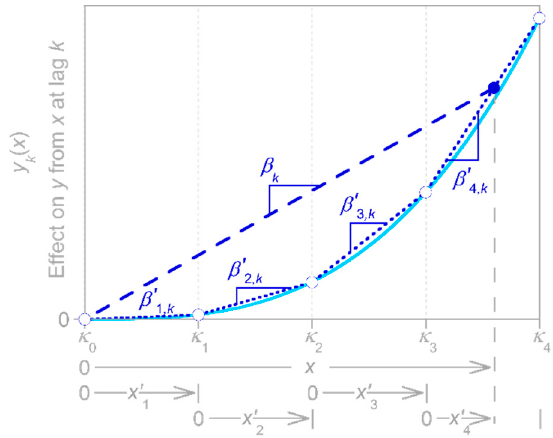
Figure 8. Broken ‐ stick approximation to nonlinear impulse response. Schematic of the (unknown) Figure 8. Broken-stick approximation to nonlinear impulse response. Schematic of the (unknown) nonlinear dependence of output 𝑦 on input 𝑥 at some lag 𝑘 , and its approximation by a piecewise nonlinear dependence of output y on input x at some lag k , and its approximation by a piecewise linear linear function defined by knots 𝜅 ℓ and the associated slopes 𝛽 ℓ,(cid:3038)(cid:4593) of each segment between suc ‐ function defined by knots κ (cid:96) and the associated slopes β (cid:48) of each segment between successive knots. (cid:96) , k cessive knots. The increments 𝑥 ℓ(cid:4593) of 𝑥 within each segment, as illustrated below the 𝑥 axis, facili ‐ The increments x (cid:48) of x within each segment, as illustrated below the x axis, facilitate the estimation of tate the estimation of the impulse response coefficient 𝛽 (cid:3038) via broken ‐ stick regression, as described (cid:96) the impulse response coefficient β k via broken-stick regression, as described in Equations in Equations (41)–(46). For any given value of 𝑥 , such as the value indicated by the dashed gray line, the system response is approximated by the corresponding point on the piecewise linear curve (the solid blue circle). This response equals the product of the vector of increments 𝑥 ℓ(cid:4593) and the vector of the associated slopes 𝛽 ℓ,(cid:3038)(cid:4593) . The impulse response coefficient 𝛽 (cid:3038) is this integral divided by 𝑥 (i.e., the slope of the dashed blue line). The knots 𝑥 (cid:3404) 𝜅 ℓ are specified by the user. The corresponding segment slopes 𝛽 ℓ,(cid:3038)(cid:4593) , determined by fitting Equation ( 44 ) to time series of 𝑥 and 𝑦 , can be used to infer the associated values of 𝑦 (cid:3038) (cid:4666)𝑥 (cid:3404) 𝜅 ℓ (cid:4667) and thus to estimate the nonlinear dependence of 𝑦 on 𝑥 at each lag 𝑘 . The knots divide the range of 𝑥 into 𝑛 (cid:3089) discrete intervals. They thus permit each value of 𝑥 to be expressed in terms of a corresponding vector 𝑥 ℓ(cid:4593) of the increments of 𝑥 that lie within each interval. The 𝑛 (cid:3089) elements of 𝑥 ℓ (cid:4593) express how much of each interval between knots lies at or below any given value of 𝑥 : 𝑥 (cid:3404) (cid:3533) 𝑥 ℓ(cid:4593)(cid:3041) (cid:3337) ℓ(cid:2880)(cid:2869)